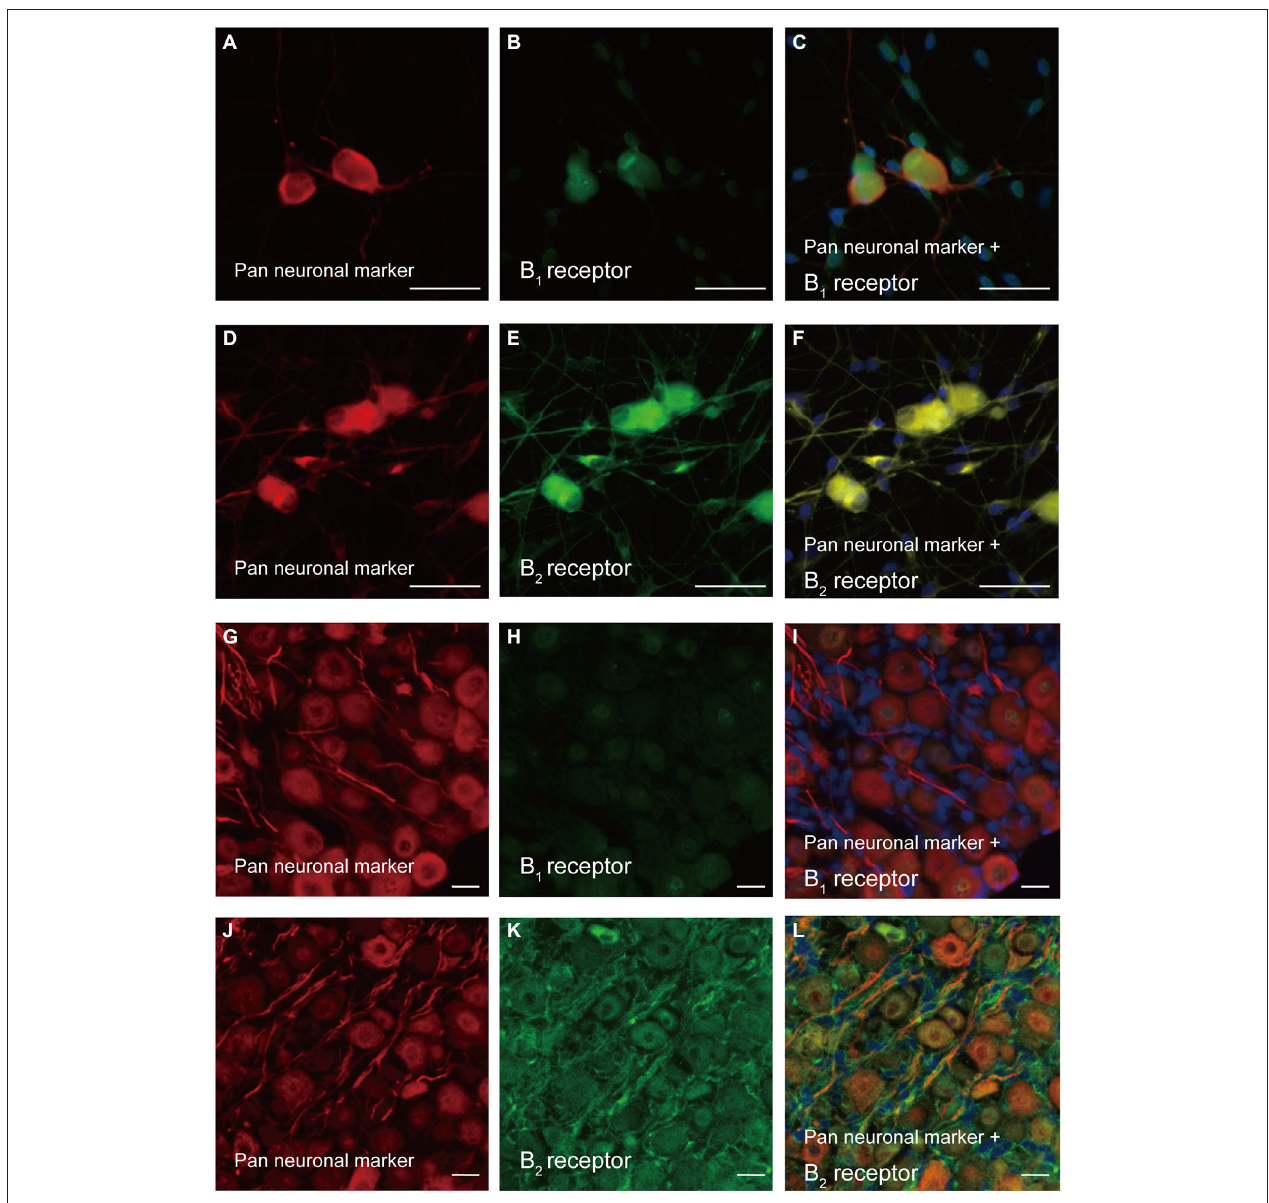
antibody (green) in primary cultured TG neurons (E) and TG cryosections (K) . (F,L) Triple immunofluorescence staining with antibodies against the pan neuronal marker (red) and B 2 receptor (green) in primary cultured TG neurons (F) and TG cryosections (L) . Nuclei are shown in blue. Scale bars are 50 µ m in (A–F) , and 20 µ m in (G–L) . Each set of images showing representative immunolocalization of B 1 (A–C) and B 2 receptors (D–F) in primary cultured TG neurons was obtained from six different rats, while that showing immunolocalization of B 1 (G–I) and B 2 receptors (J–L) in TG cryosections was obtained from five different